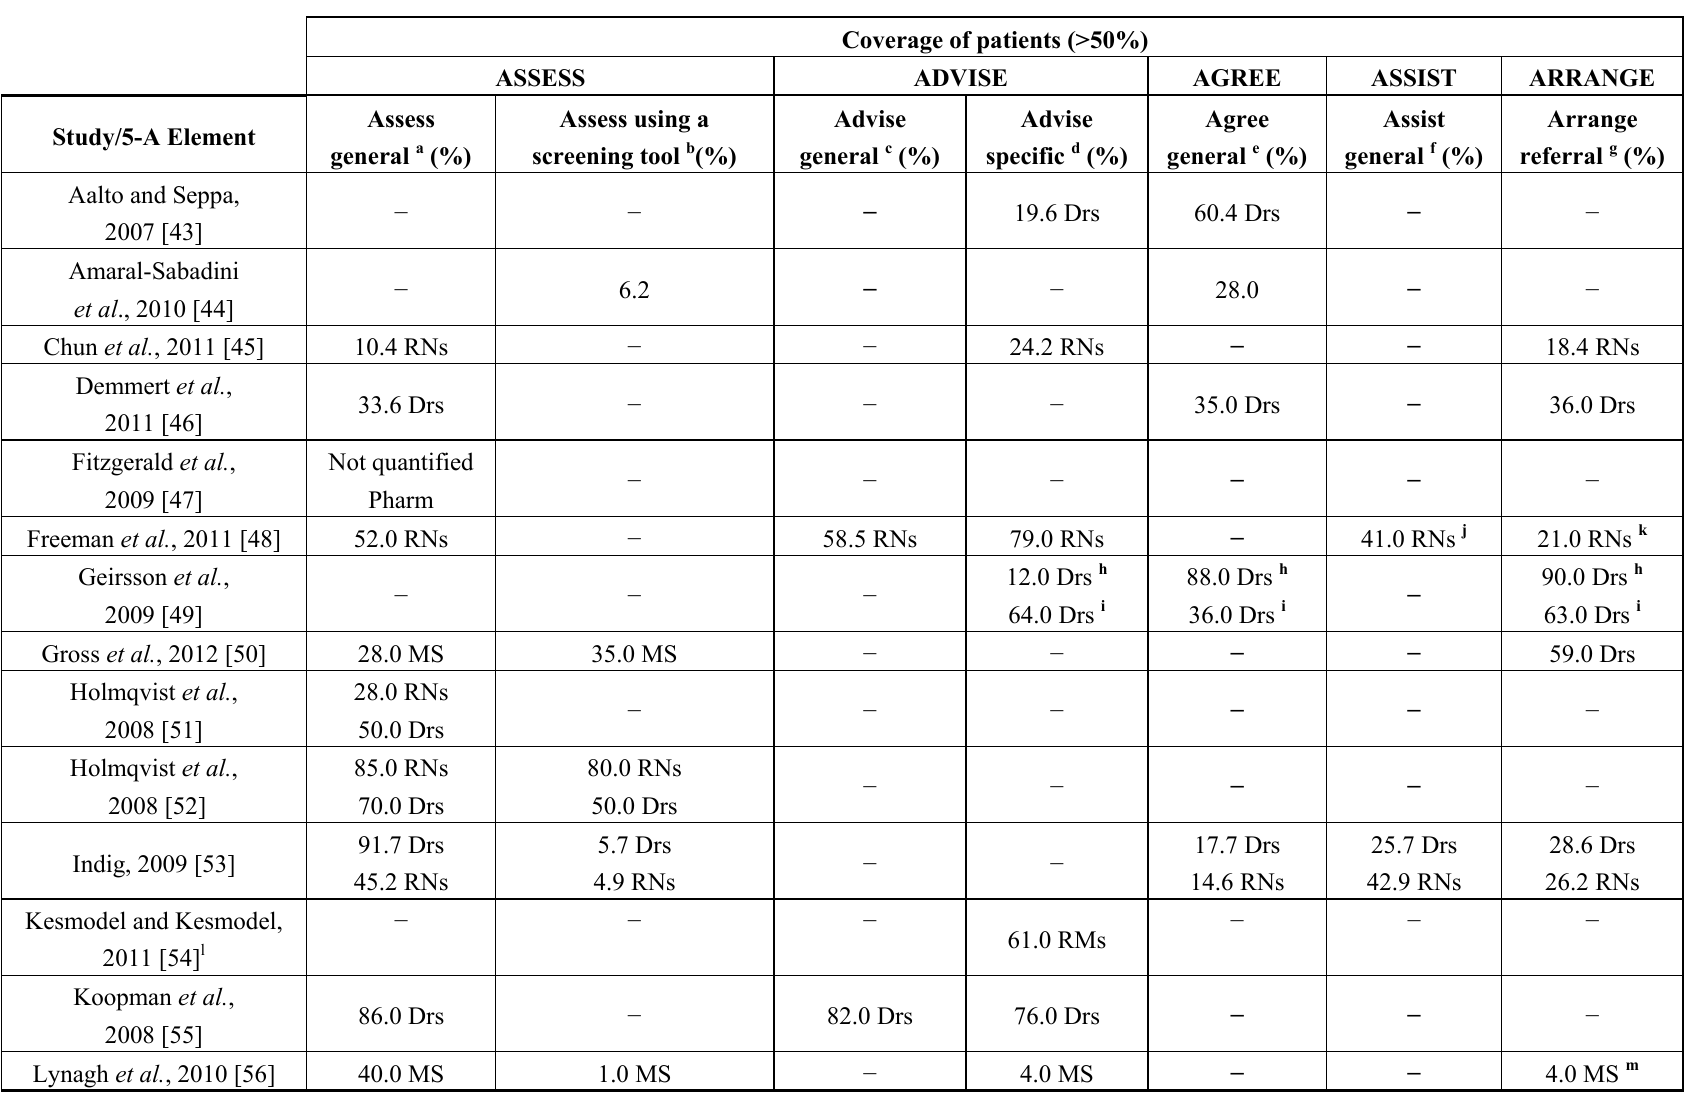
Table 4. A summary of the 5-As used in alcohol health promotion: Professional activity